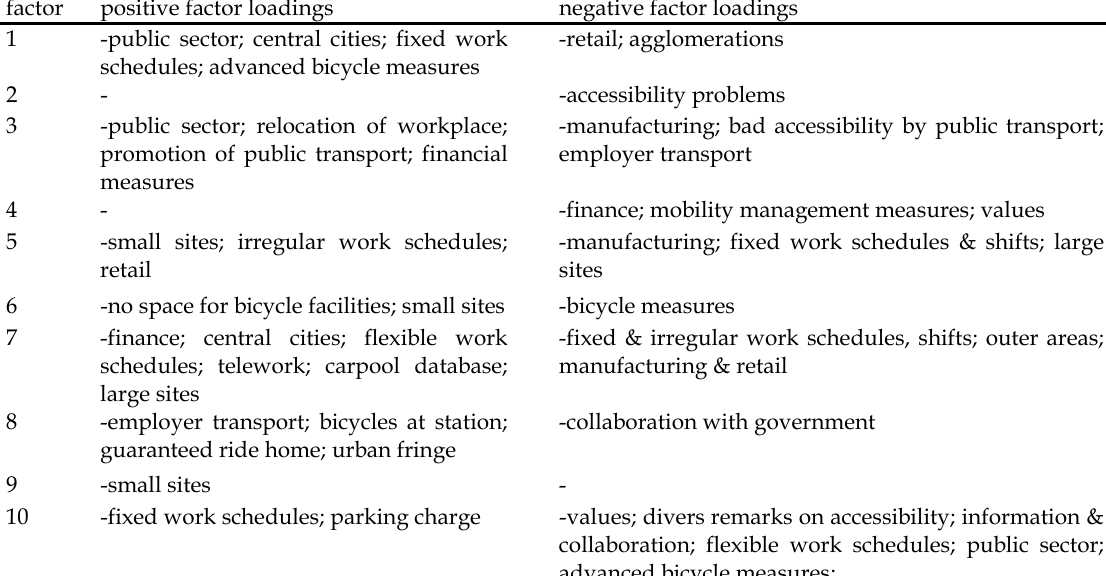
Table 2. Description of the EFA